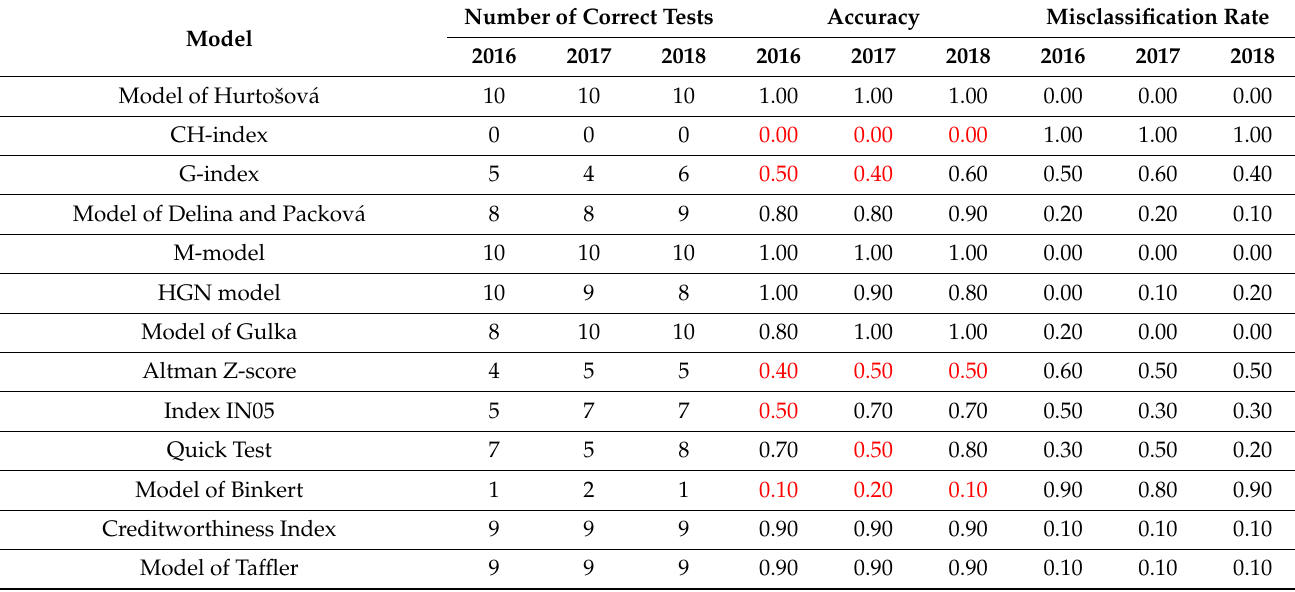
Table 4. Results of testing default prediction models on prosperous companies in tourism sector in 2016–2018.